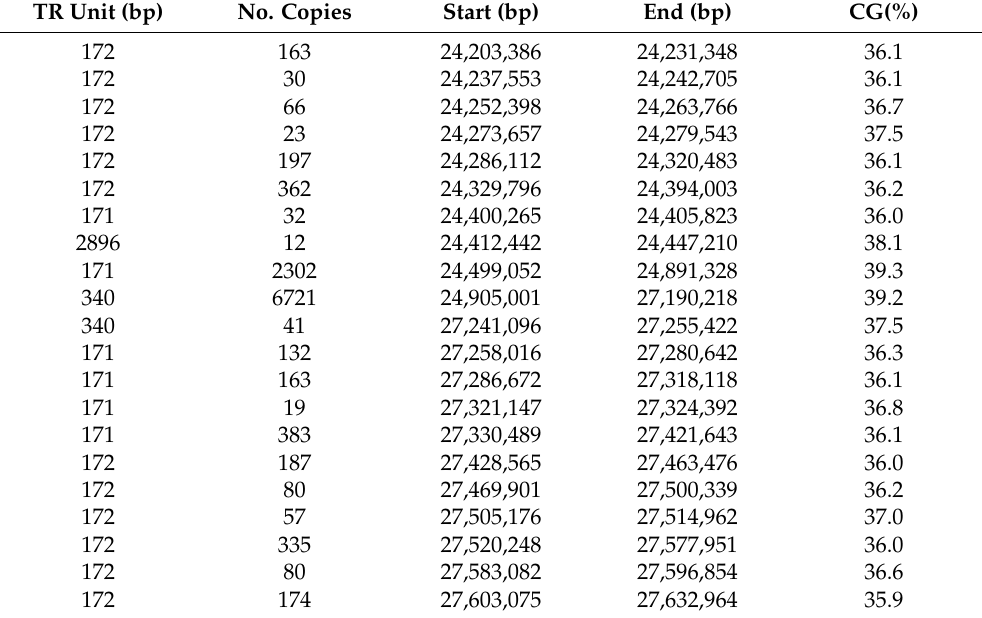
Figure 7. Distribution of repetitive sequences over TR unit length in human ( a ), chimpanzee ( b ) and mouse ( c ) chromosome 19. ( a – c ) The range of the abscissa is limited to TRs of length 400 bp for better visibility. ( d ) Radar chart with the proportion of bases in TR, divided into five groups according to the length of the basic TR unit (0-50 bp, 51 - 100 bp, 101-150 bp, 151-200 bp and >200 bp). Human 340 bp TRs are in most cases alpha satellite 2 mer HORs with basic ~171 bp repetitive monomer. Table 2. TRs from human chromosome 19 centromeric region. The data are result of the GRM application and are part of the analysis given in Supplementary Table 1. Some of ~171 bp alpha satellite arrays in table are additionally organized in HORs as can be concluded from Figure 6 (left side of Fragment diagram).